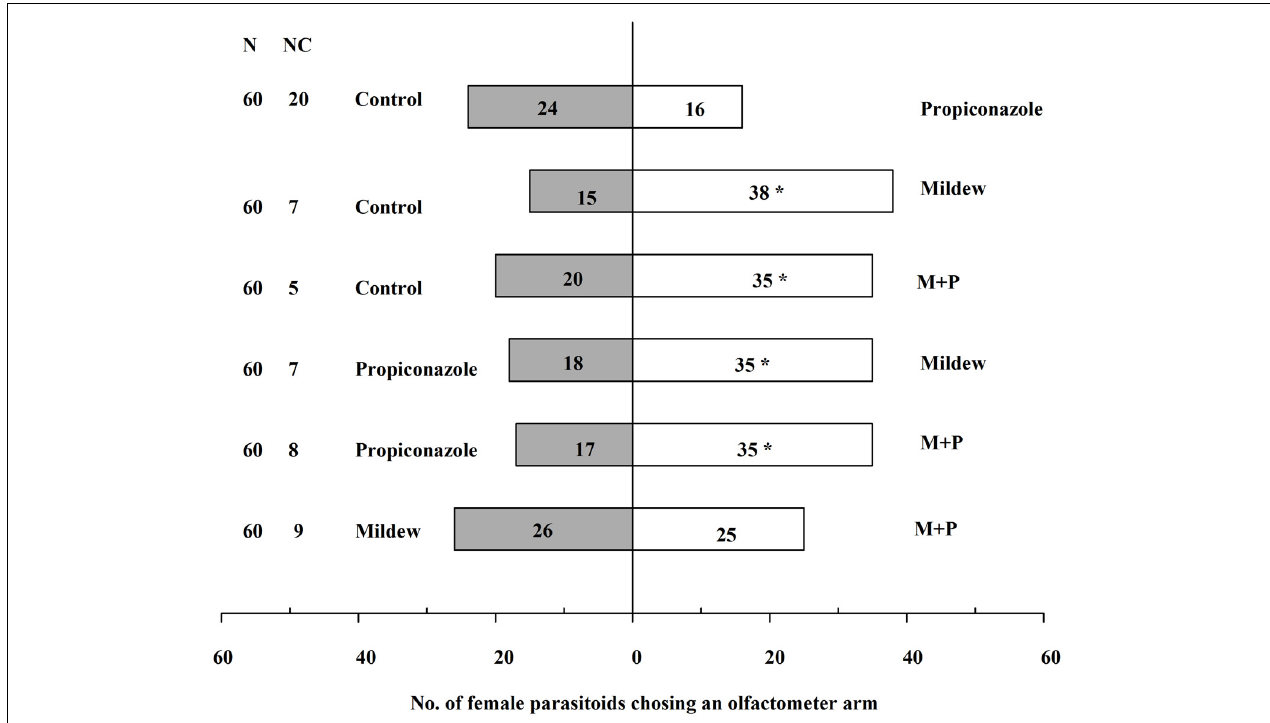
FIGURE 8 | Preference of A. gifuensis among the different